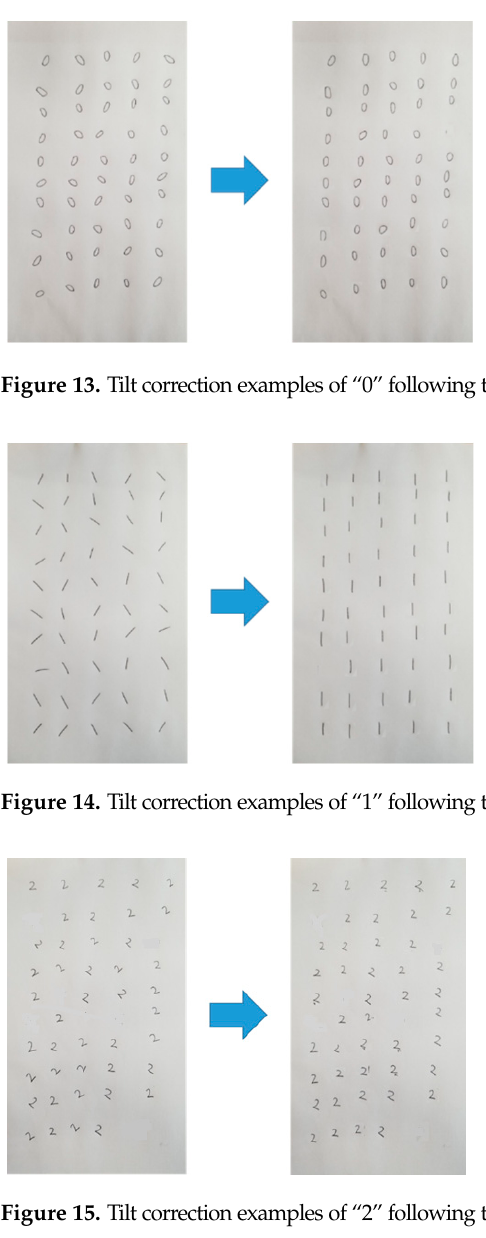
Figure 17. Tilt correction examples of “4” following the proposal ( left : original, right : tilt correction results).